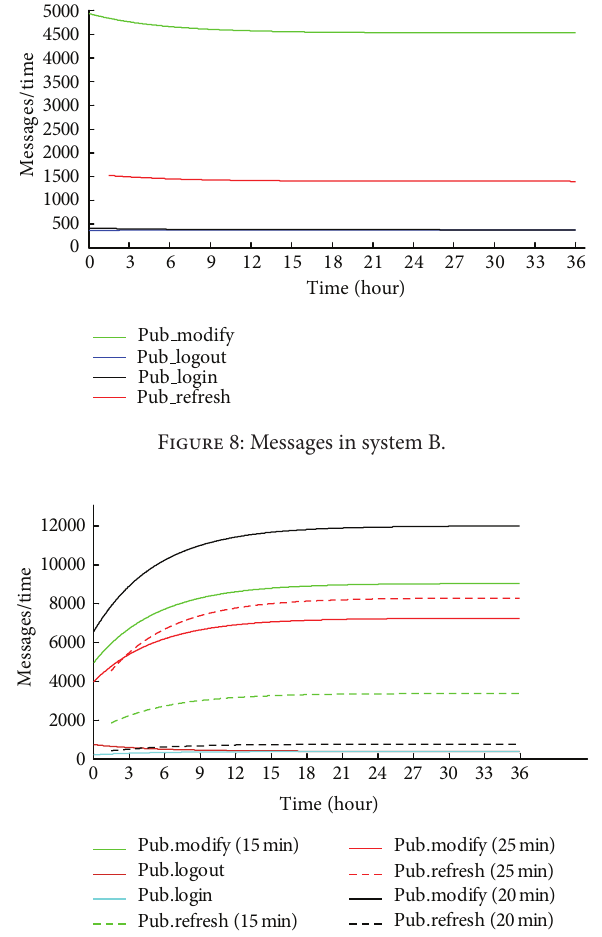
Figure 9: System A with increasing amount of messages.